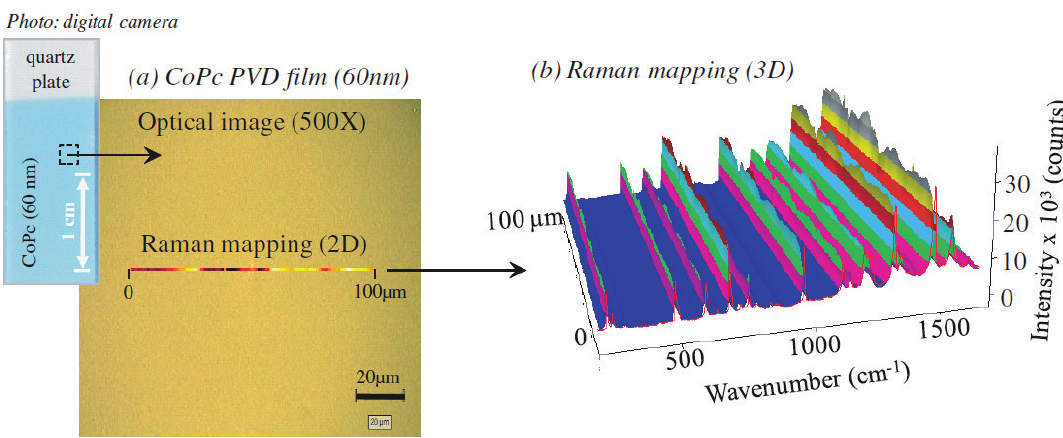
Figure 7 - ( a ) Optical image for a 60 nm CoPc PVD fi lm and the line (1 µm), which represent the region used to record the Raman mapping with a 1 µm step (band intensity at 1463 cm -1 ). ( b ) 101 Raman spectra recorded along mapping line. Reprinted with permission (Alessio et al.